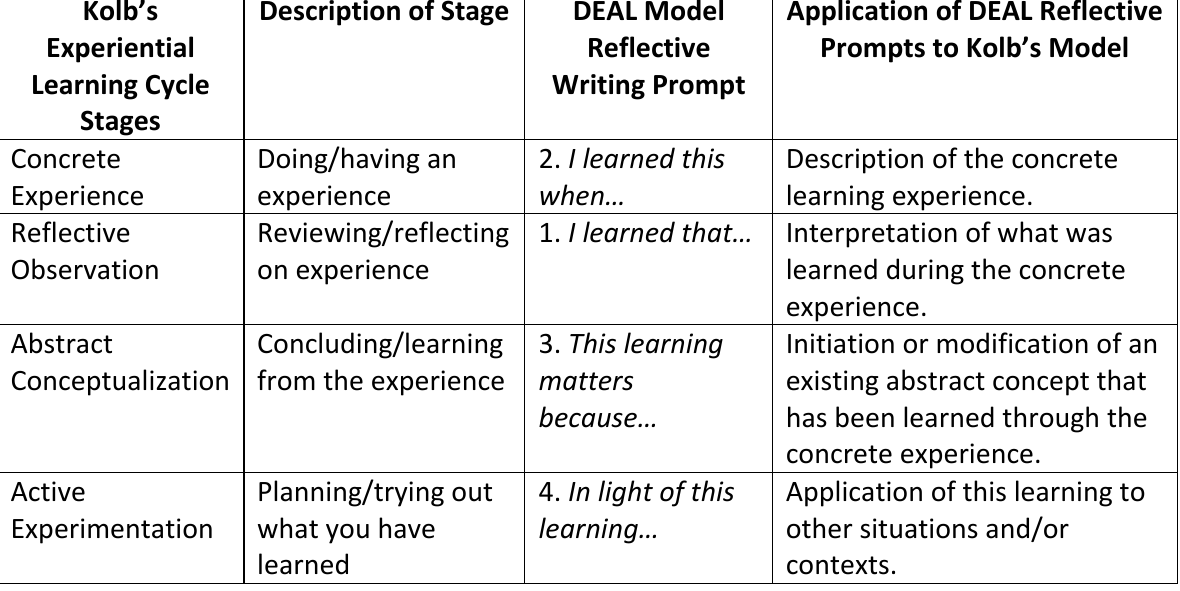
Kolb’s Experiential Learning Cycle Stages Mapped to DEAL Model Reflective